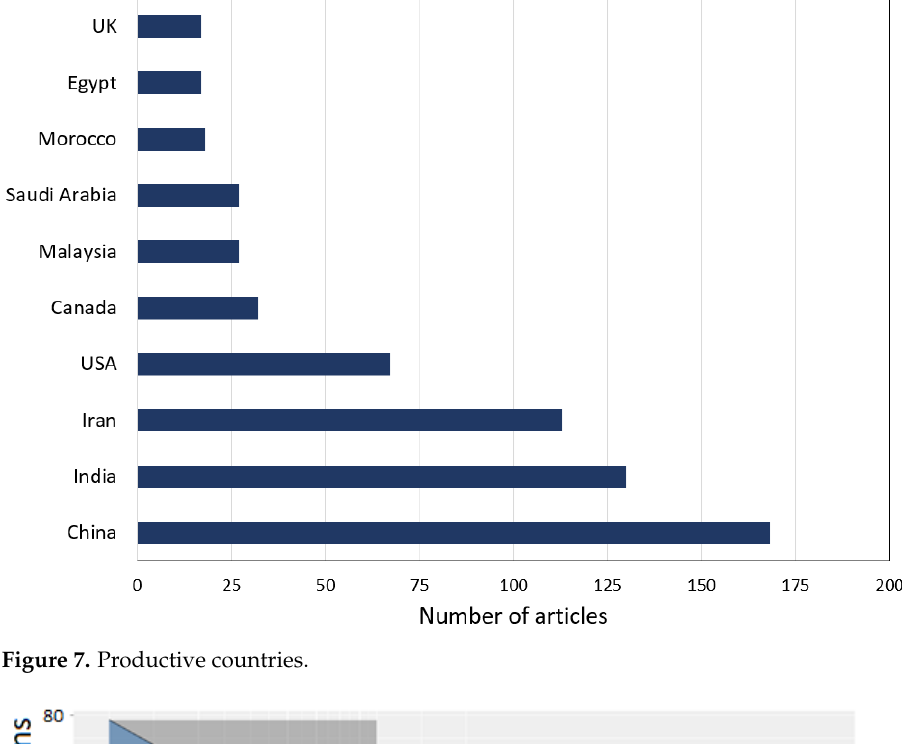
Figure 7. Productive countries.